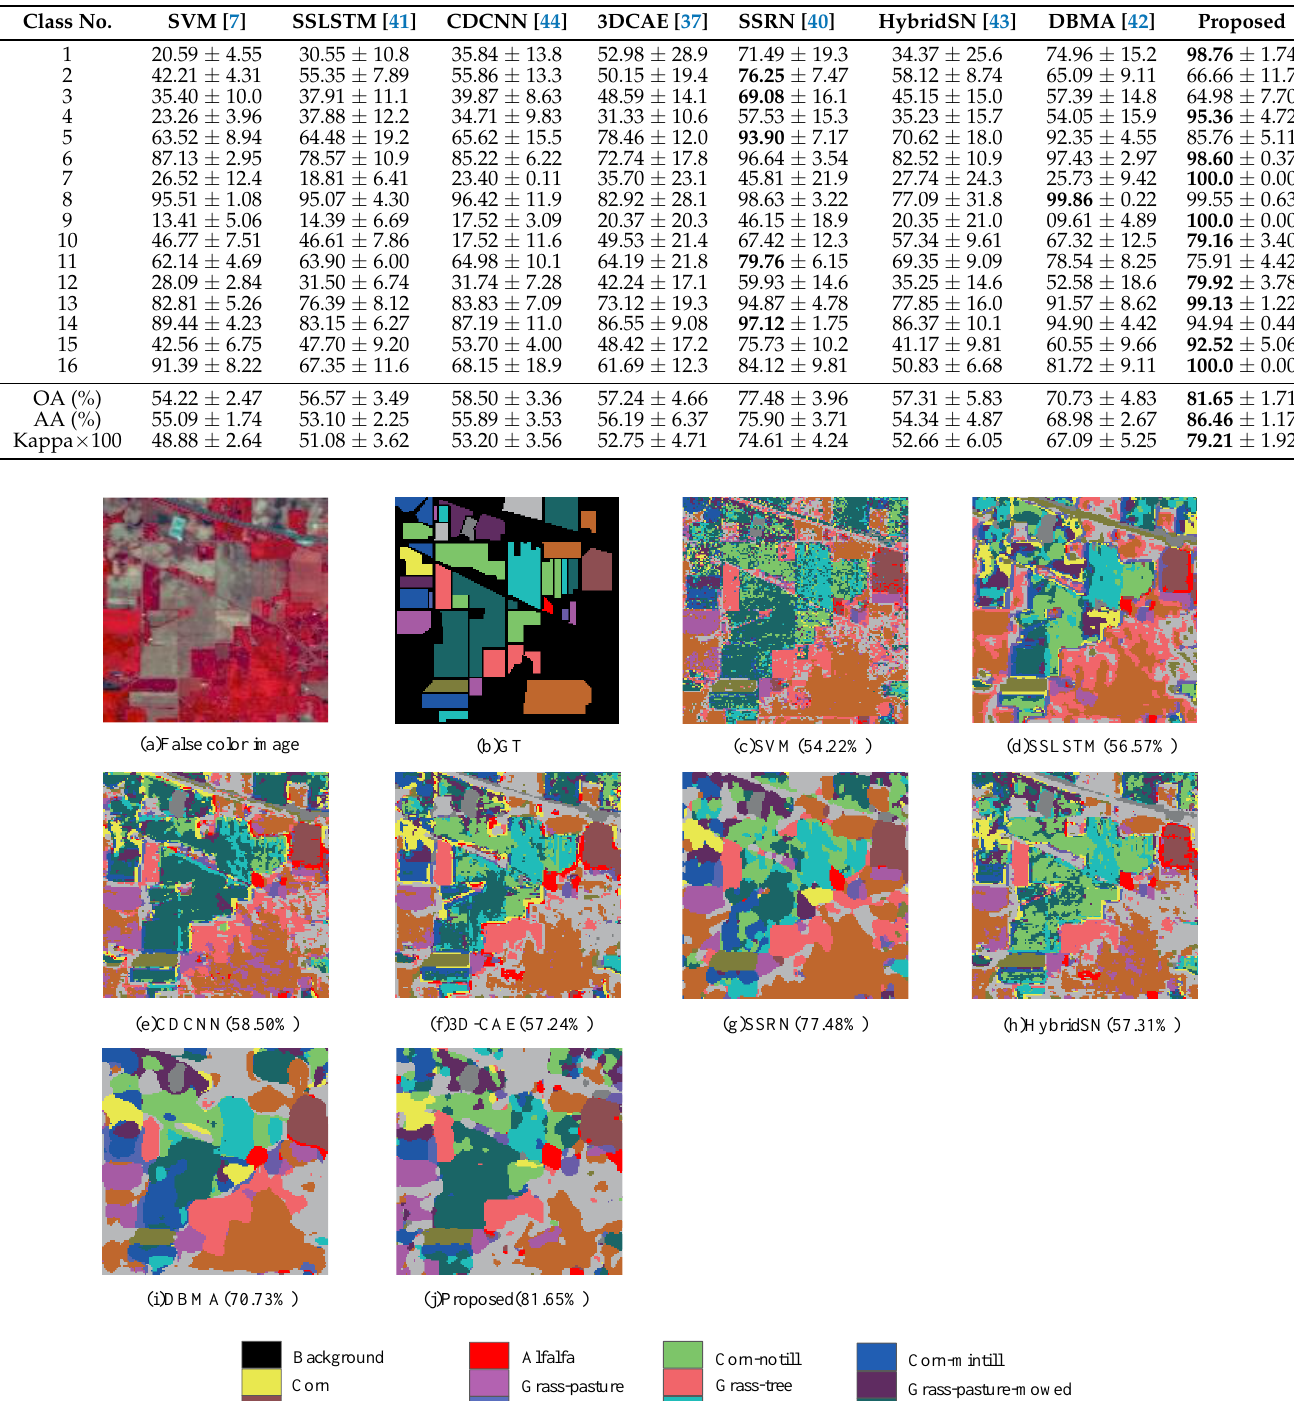
Table 5. Classification results on the Indian Pines dataset with 10 labeled samples, including OA (%), AA (%) and Kappa × 100 in which the best results are denoted in bold.